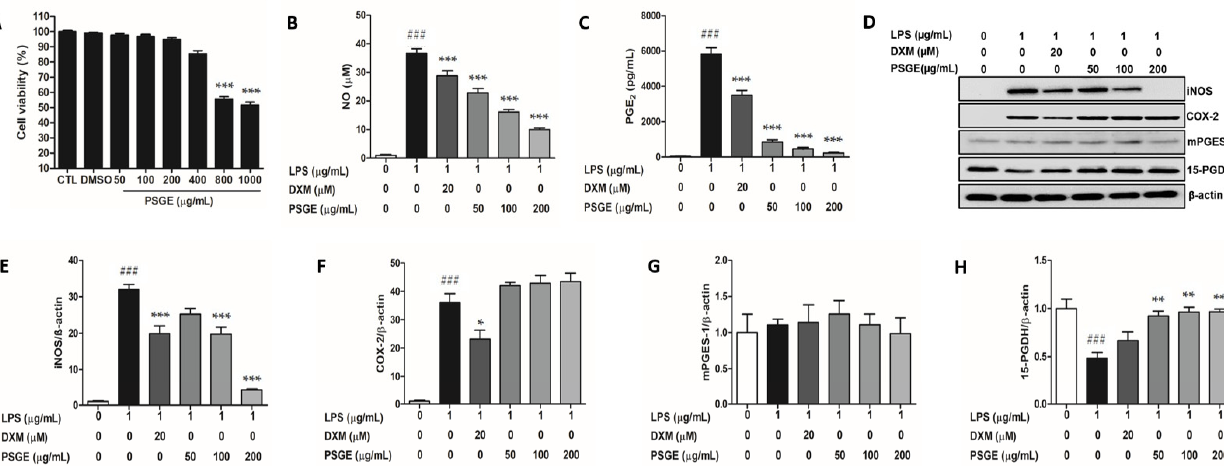
Figure 2. Cell viability and effects of PSGE against LPS-induced NO and PGE 2 production and related iNOS, COX-2, mPGES-1 and 15-PGDH expression in RAW 264.7 cells. ( A ) Cell viability of PSGE in RAW 264.7 cells. RAW 264.7 cells were treated with 50 − 1000 µ g/mL of PSGE for 24 h and cell viability was determined by MTT assay. ( B ) NO levels were measured by Griess assay, ( C ) PGE 2 levels were measured by ELISA assay, ( D ) Protein expression and quantitative analysis of ( E ) iNOS, ( F ) COX-2, ( G ) mPGES-1 and ( H ) 15-PGDH expression relative to β -actin. RAW 264.7 cells were pre-treated with indicated concentration of PSGE or DXM for 2 h followed by LPS for 24 h. DXM was used as positive control. Data shown represent mean ± SEM ( n = 3). (### p < 0.001 vs. control; * p < 0.05, ** p < 0.01, and *** p < 0.001 vs.